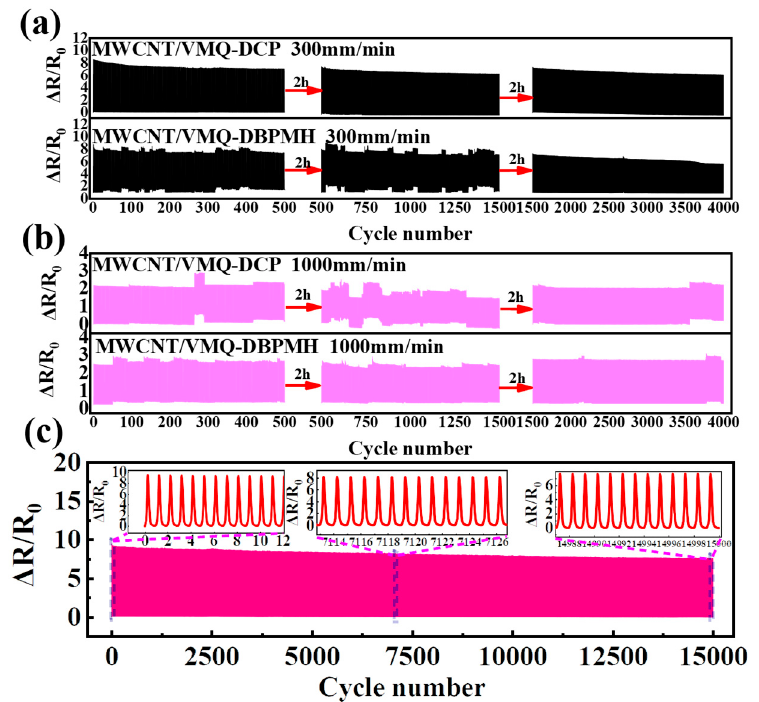
Figure 6. ( a ) The resistance of the MWCNT/VMQ-DCP composites and the MWCNT/VMQ-DBPMH composites under 300 mm/min rates of cyclic strain. ( b ) The resistance of the MWCNT/VMQ-DCP composites and the MWCNT/VMQ-DBPMH composites under 1000 mm/min rates of cyclic strain. ( c ) The resistance of the MWCNT/VMQ-DCP composites under a strain of 15,000 cycles.